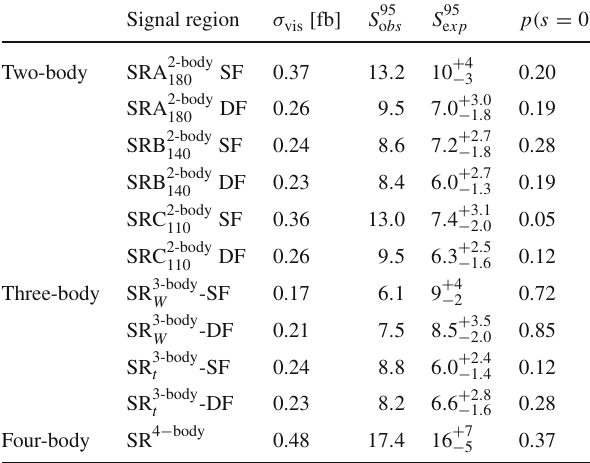
Fig. 10 Exclusion contour for a simplified model assuming ˜ t 1 pair ± production, decaying via ˜ t 1 → b ˜ χ 1 with 100% branching ratio. The = lightest chargino mass is assumed to be close to the stop mass, m ˜ χ ± 1 − 10 GeV. The dashed grey line and the shaded yellow band are m ˜ t 1 the expected limit and its ± 1 σ uncertainty. The thick solid red line is the observed limit for the central value of the signal cross-section. The expected and observed limits do not include the effect of the theoretical uncertaintiesinthesignalcross-section.Thedottedlinesshowtheeffect on the observed limit when varying the signal cross-section by ± 1 σ of the theoretical uncertainty. The shaded blue area shows the observed √ s = 8 TeV analysis exclusion from the ATLAS